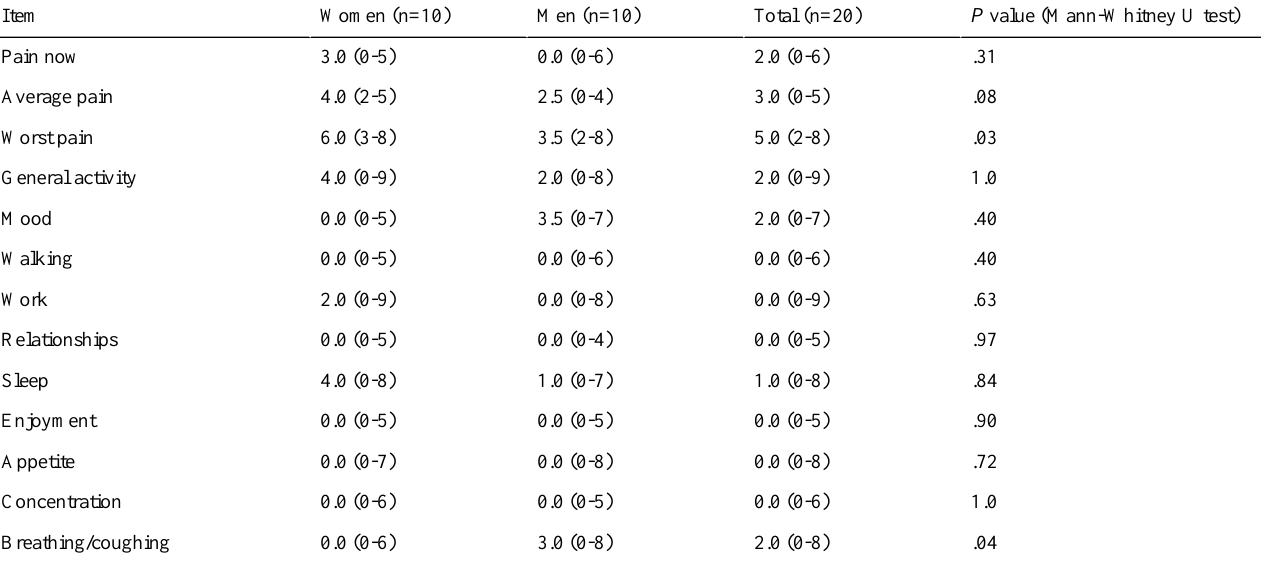
Table 4. Median (minimum-maximum) of pain intensity and interference with activities in the last 7 days, according to the BPI.